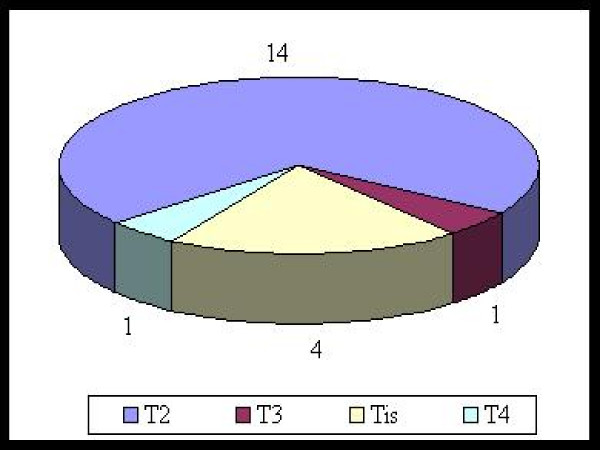
Dsitribution of patients according to the tumour size (T). Tis: carcinoma insitu.